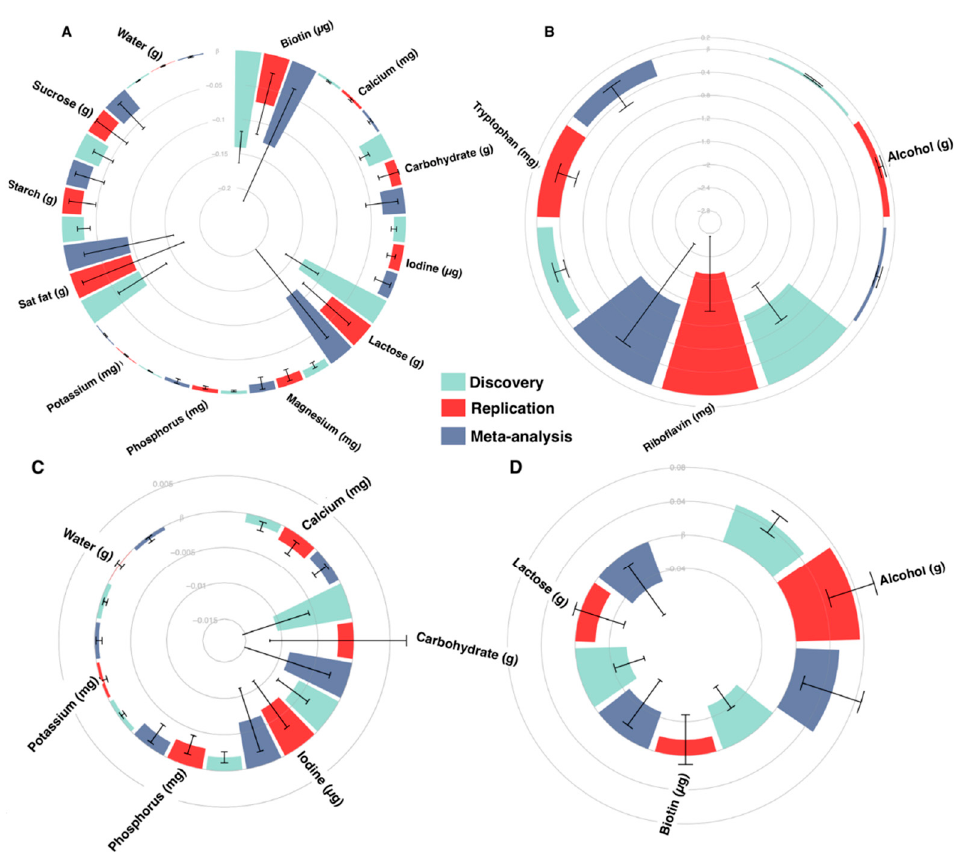
Figure 1. Meta-analysed nutrient associations with blood pressure. Nutrient-BP associations from the discovery population (False Discovery Rate (FDR) < 0.05), replication population (P < 0.05 or same direction beta) and meta-analysis. Because of the scale and comparative differences of effects, panels display varying effect sizes to facilitate visualisation of effects. SBP associations are illustrated in panels ( A ) (Beta: − 0.2 to 0) and ( B ) (Beta: − 2.8 to 0.2), and DBP associations are illustrated in panel ( C ) (Beta: − 0.015 to 0.005) and ( D ) (Beta: − 0.04 to 0.08). Error bars display SE. Results from the discovery cohort are represented in teal, from the replication cohort in red and from meta-analyses in blue.